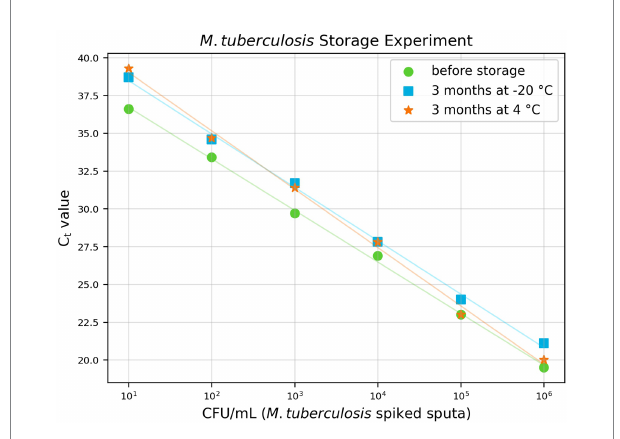
FIGURE 3 Real-time PCR C t values before storage and following 3-month storage at 4 ° C and at − 20 ° C. Tests carried out on sputa spiked with M. tuberculosis at 6 concentrations ranging from 10 1 to 10 5 CFU/mL (colony-forming units/mL). Plot gives the mean of experimental duplicates. Workflow: Sample => DNA isolation =>